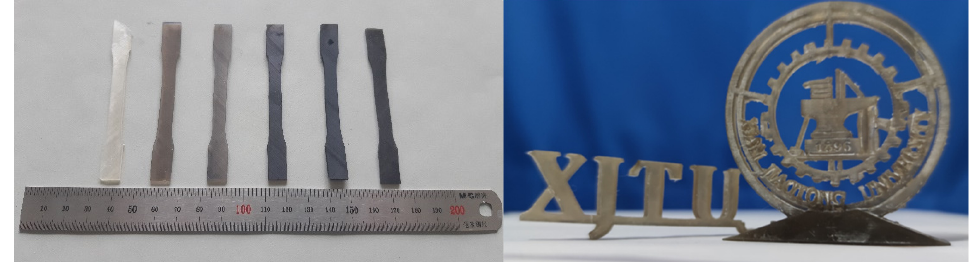
Figure 3. Tensile test specimens with increasing GO concentration from 0 to 0.5 wt.%. XJTU logo and text printed from 0.5 wt.% nanocomposite.